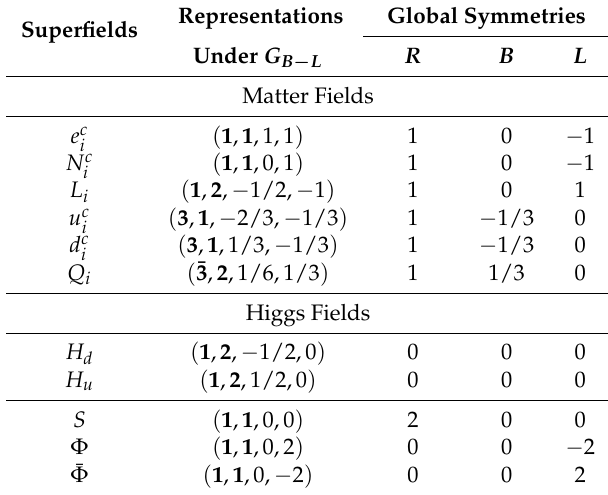
Table 1. The representations under G B